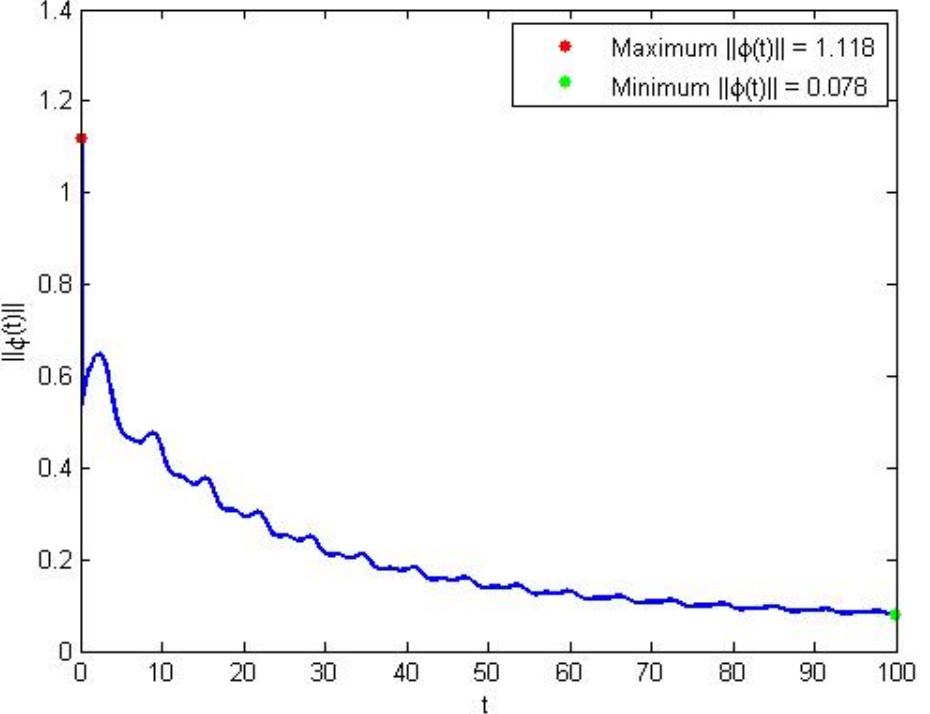
Figure 8. || ϕ ( t ) || for system (7), with α = 0.7, ρ = 0.5, and w ( t ) = [ 2 sin ( t )] T Figure 8. ‖𝜑(𝑡)‖ for system (7), with 𝛼 = 0.7 , 𝜌 = 0.5, and 𝑤(𝑡) = [2 𝑠𝑖𝑛(𝑡)] 𝑇 .